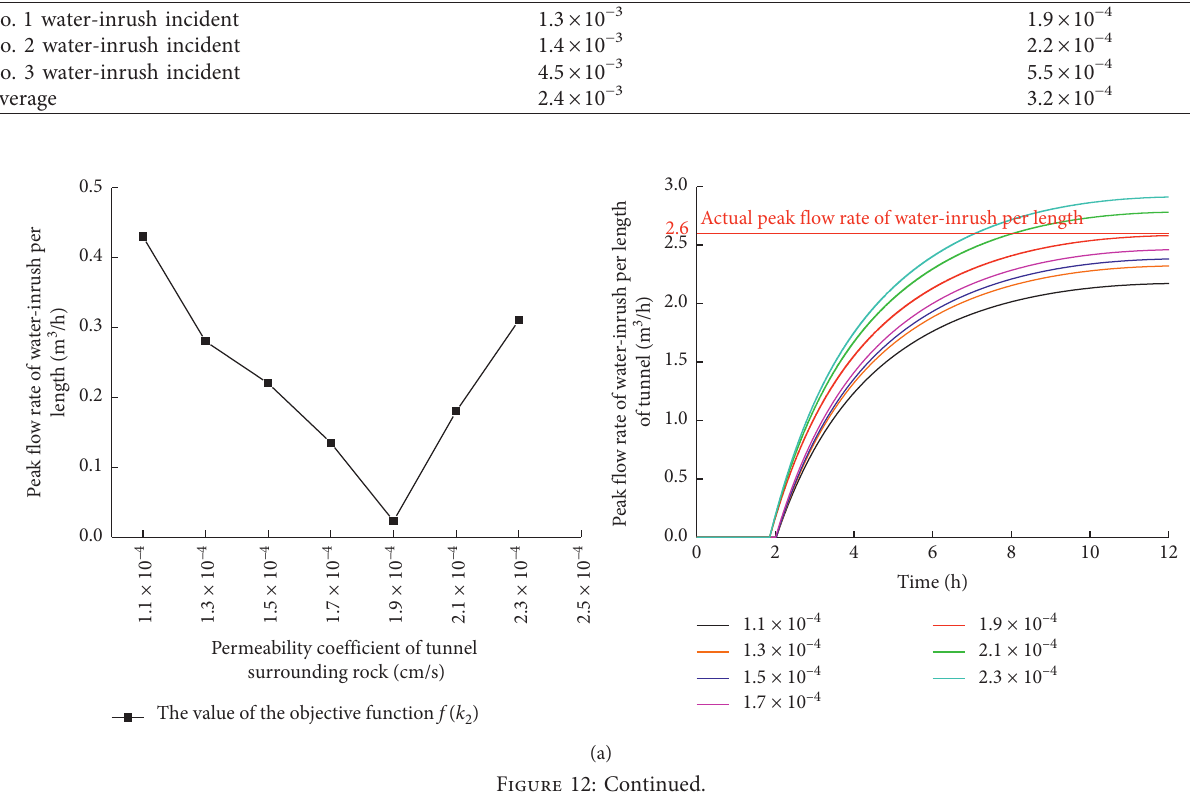
Figure 11: Relationship between objective function and the permeability coefficient of the karst infiltration zone: (a) No. 1 water-inrush incident; (b) No. 2 water-inrush incident; (c) No. 3 water-inrush incident. Table 11: Permeability coefficient of inversion analysis. Karst infiltration zone (cm/s) Tunnel surrounding rock